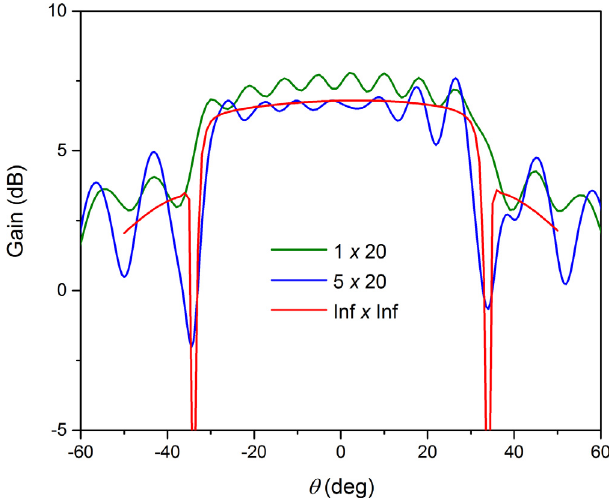
Figure 4. Element radiation pattern of a 1 row of 20 elements array (element #10), a 5 rows of 20 elements array (element #50) and an infinite array.